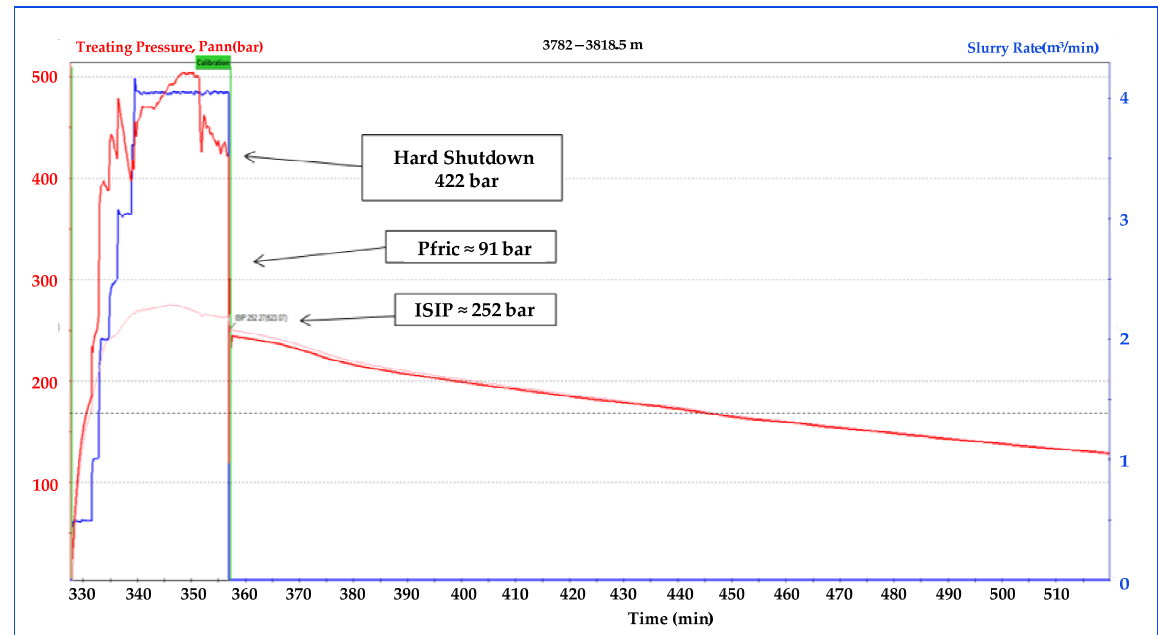
Figure 6. tep rate test (SRT) test diagram [3].